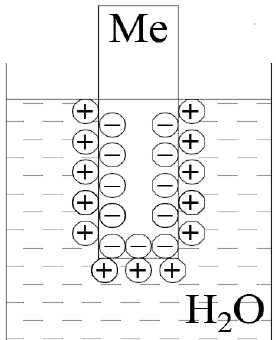
Figure 4. EDL system when putting a metal electrode into water.